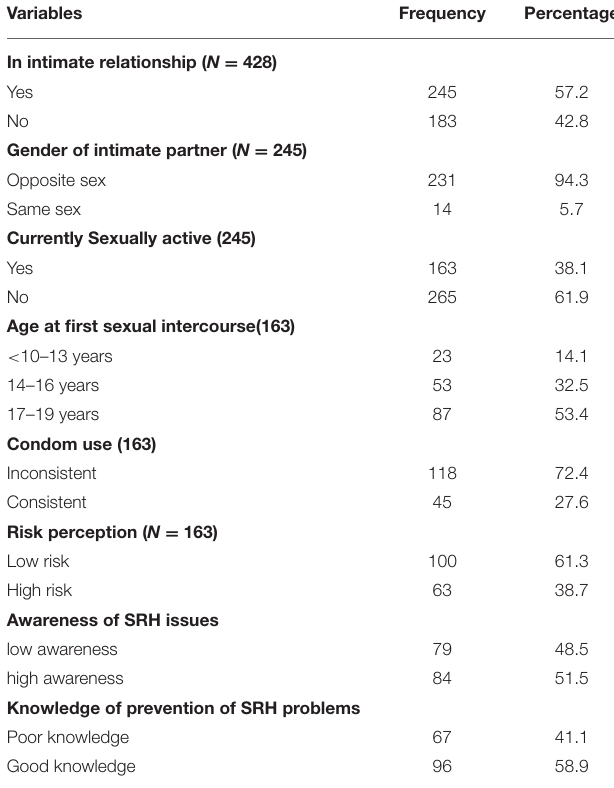
TABLE 2 | Sexual experience, risk perceptions and awareness of SRH among adolescents in Plateau State, Nigeria.